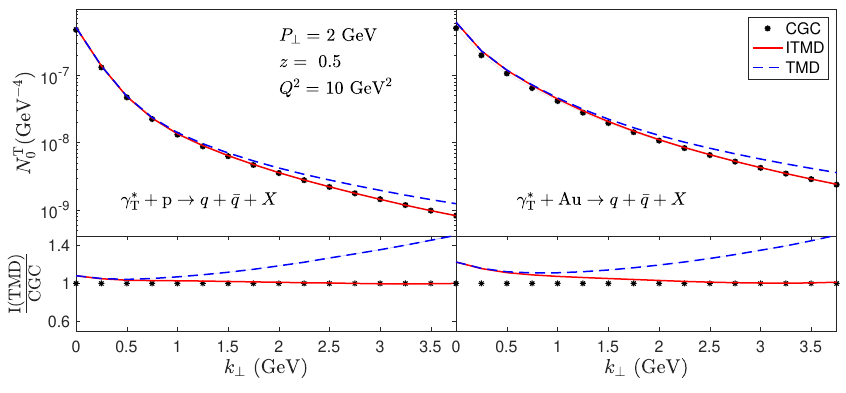
and φ k ) for production ⊥ ⊥ + p (left) and γ ∗ + Au (right) scattering. Bottom: ratio of the T T